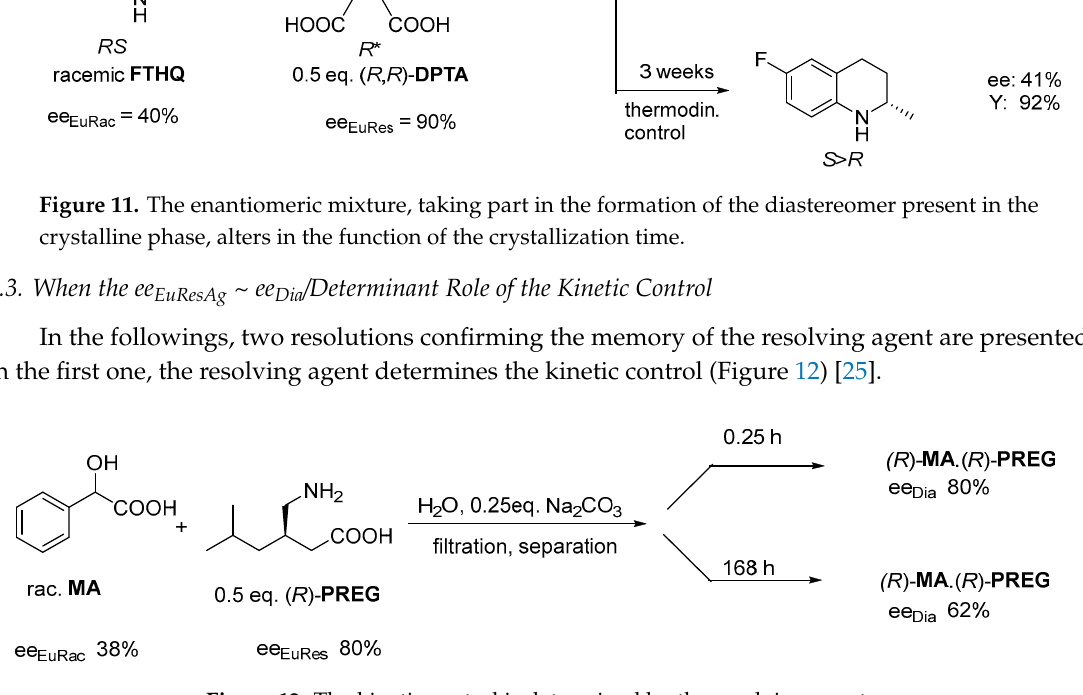
Figure 12. The kinetic control is determined by the resolving agent.